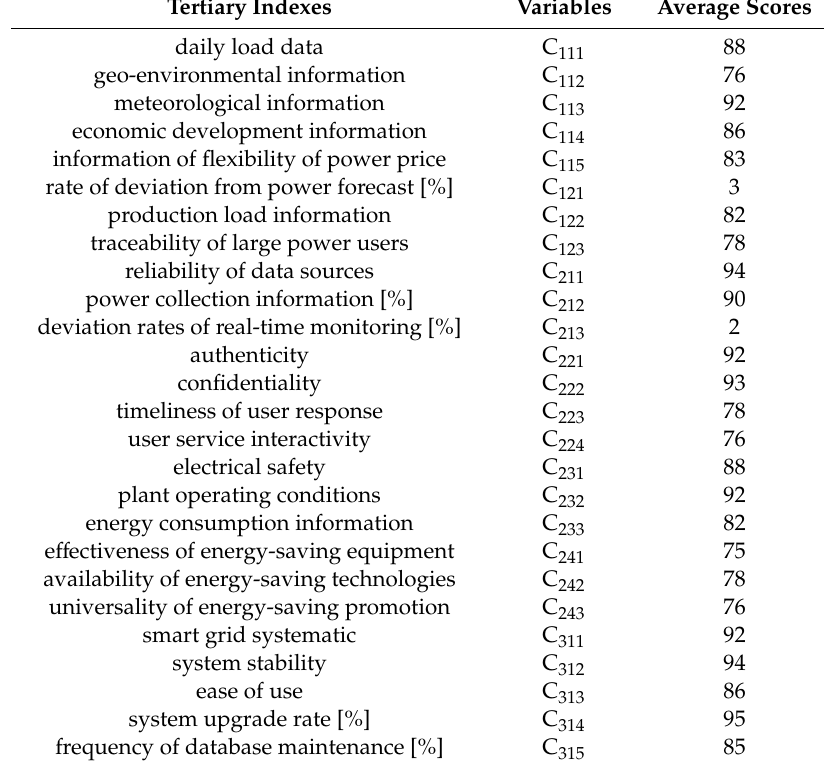
Table 7. Indexes